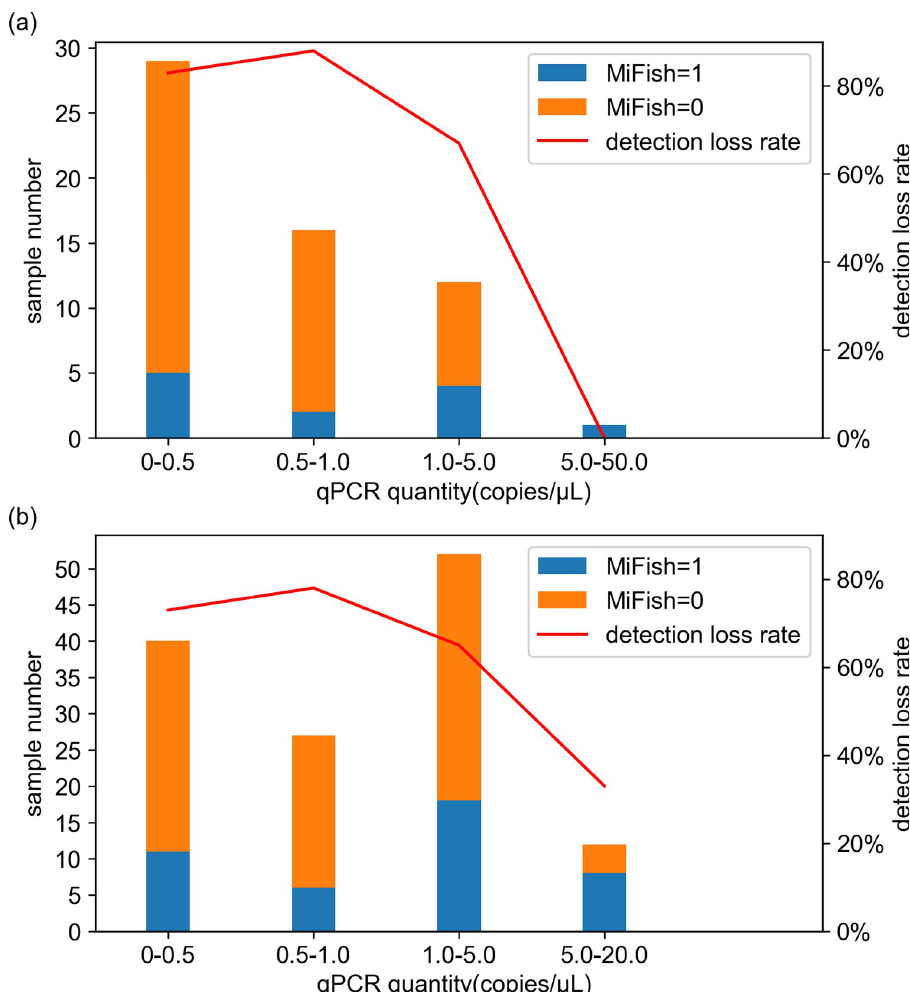
Fig 7. Comparison of MiFish presence/absence detection samples based on OceanDNA quantity measured by qPCR. (a) Result of chub/blue mackerel ( Scomber japonicus and Sc . australasicus ) and (b) result of sardine ( Sardinops melanostictus ). The figures were prepared from pooling data of B-line and C-line. Samples in which qPCR did not detect OceanDNA are not included in this figure. Numbers in x axis represent the OceanDNA quantity (copies/ μ L) measured by qPCR.